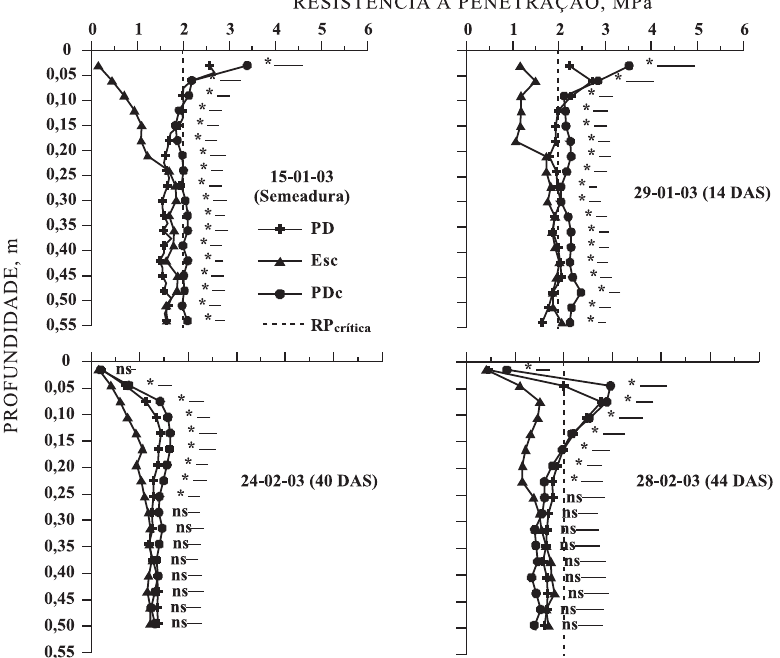
Figura 3. Resistência à penetração para quatro datas durante o ciclo da cultura do feijoeiro em Latossolo sob plantio direto contínuo (PD), plantio direto com compactação adicional (PDc) e com escarificação (Esc). Barras horizontais comparam os valores de RP, por profundidade, pelo teste DMS (5 %). (ns: não- significativo;